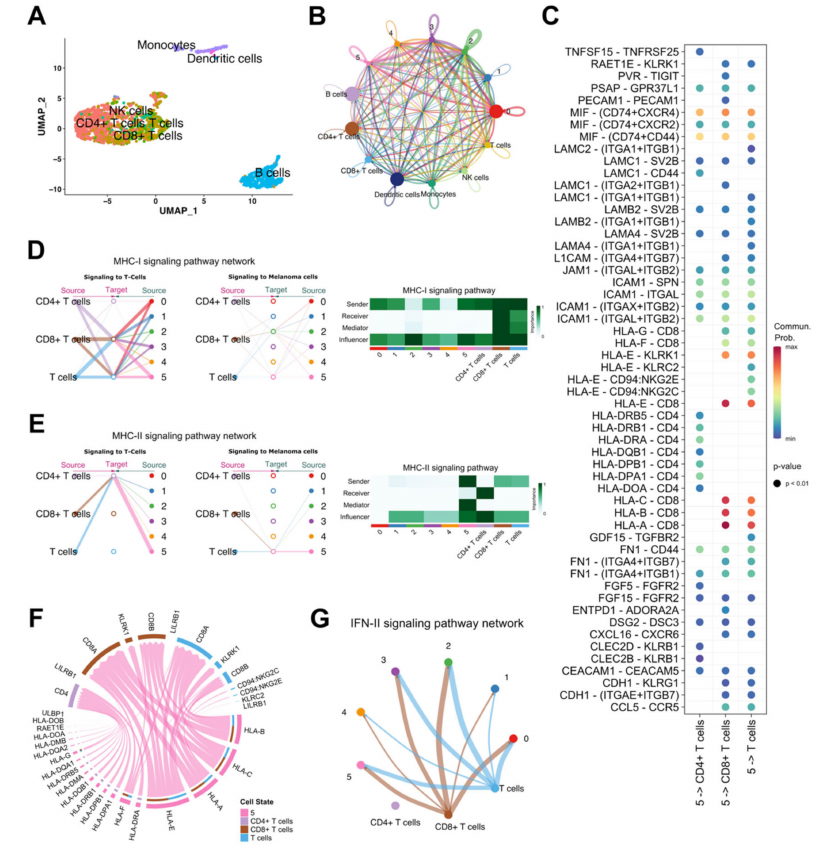
Figure 3. Cell–cell interaction between melanoma and immune cell clusters . ( A ) UMAP plot of aggregated immune cells from the GSE115978 dataset. Immune cells are automatically annotated with SingleR (R package), based on the Monaco Immune Database. Monocytes, dendritic cells, B cells, NK cells, T cells, CD8 + T cells, and CD4 + T cells could be identified. ( B ) Aggregated network of cell–cell communication, based on the total number of interactions. ( C ) Dot plot showing all the significant ligand–receptor interactions between cluster 5 and T cell subtypes (T cells, CD8 + T cells and CD4 + T cells). p < 0.01 was considered as the threshold for significance. ( D ) Hierarchical plot illustrates the communication network of the MHC-I signaling pathway (left). A heatmap showing the role (based on CellChat centrality measures) of each cell cluster in the MHC-I signaling pathway (right). ( E ) Hierarchical plot (left) and centrality heatmap (right) for MHC-II signaling pathway communication network. ( F ) Chord diagram showing ligand–receptor interactions between cluster 5 and T cell subtypes within MHC (I and II) signaling pathways only. ( G ) Circle plot for IFN-II signaling